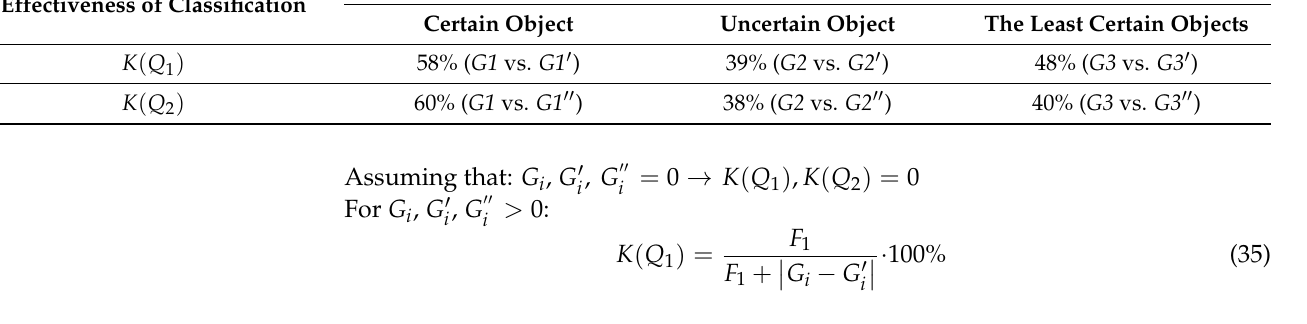
Table 10. Average values of the effectiveness of classification of hyperbolas K ( Q 1 ) and K ( Q 2 ) . Effectiveness of